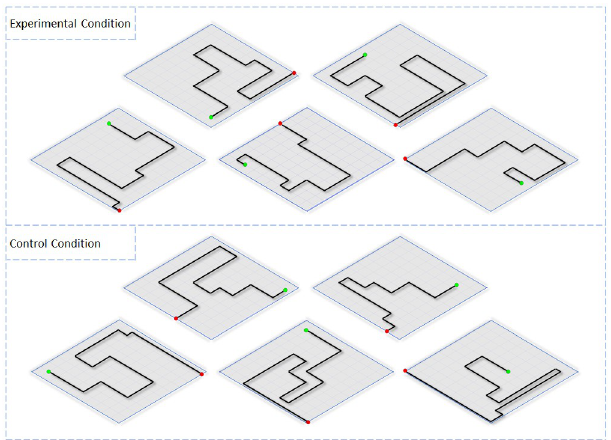
Fig 4. Virtual environments. Design of all ten virtual environments. The top five were assigned to the experimental condition, while the bottom five were assigned to the control condition. The green circles indicate the participants starting position before each session, while the red circles indicate the